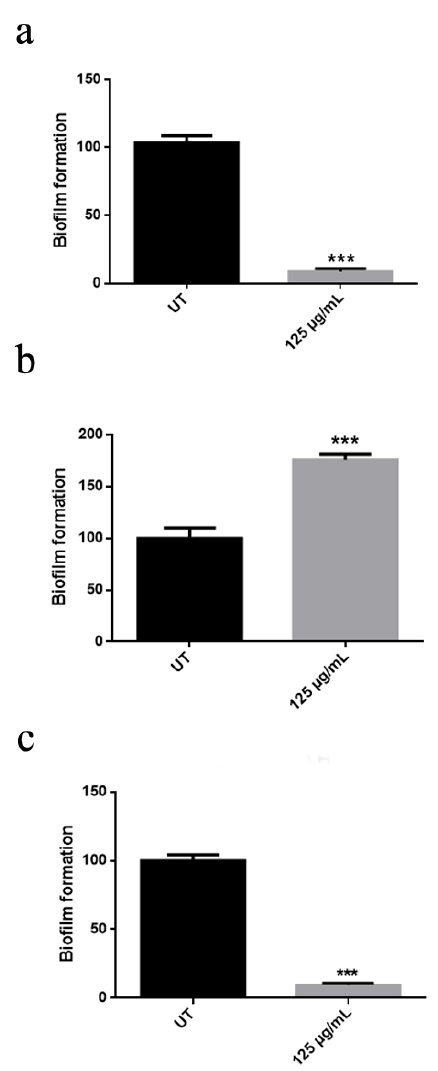
Figure 3. E ff ect of ZnO-NRs on biofilm formation. Di ff erent strains were grown in the absence (UT: untreated) or presence of 125 µ g / mL ZnO-NRs. ( a – c ) indicate respectively A. aurescens TC4, A. spanius Figure 3. Effect of ZnO-NRs on biofilm formation. Different strains were grown in the absence (UT: untreated) or presence of 125 µg/mL ZnO-NRs. ( a – c ) indicate respectively A. aurescens TC4, A. spanius TC1, and A. spanius TC7, after 24 h of treatment. For statistical analysis one-way ANOVA method coupled with the Bonferroni post-test was used (*** p < 0.001 with respect to